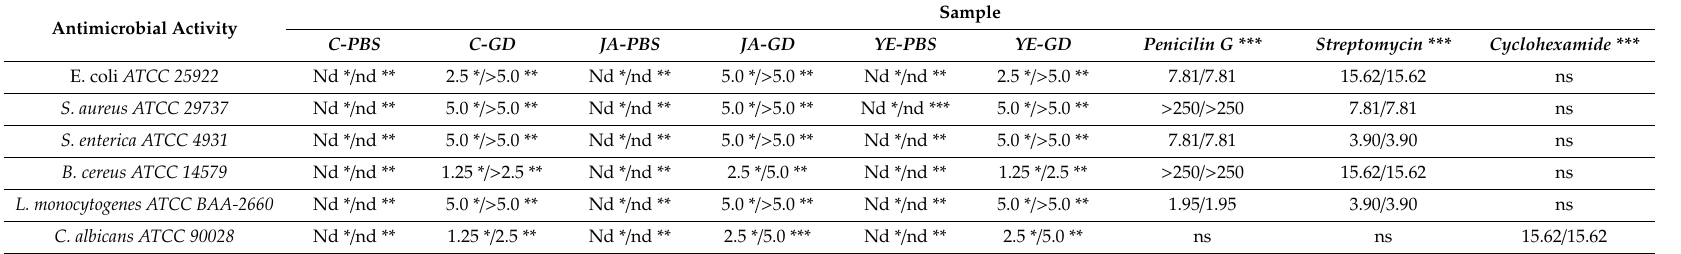
Table 4. Antimicrobial activity of the control, elicited lovage bu ff er (PBS) extracts, and gastrointestinally digested (GD) extracts against bacteria and yeast. C-PBS—PBS extracts from the control plants; JA-PBS—PBS extracts from the plants elicited with a solution of 10 µ M jasmonic acid; YE-PBS—PBS extracts from the plants elicited with 0.1% yeast extract; C-GD—gastrointestinally digested extracts from the control plants; JA-GD—gastrointestinally digested extracts from the plants elicited with a solution of 10 µ M jasmonic acid; YE-GD—gastrointestinally digested extracts from the plants elicited with a 0.1% yeast extract; MIC—minimum inhibitory concentration; MLC—minimum lethal concentrations; nd—not detected; ns—not studied. ATCC—American Type Culture Collection. Antimicrobial